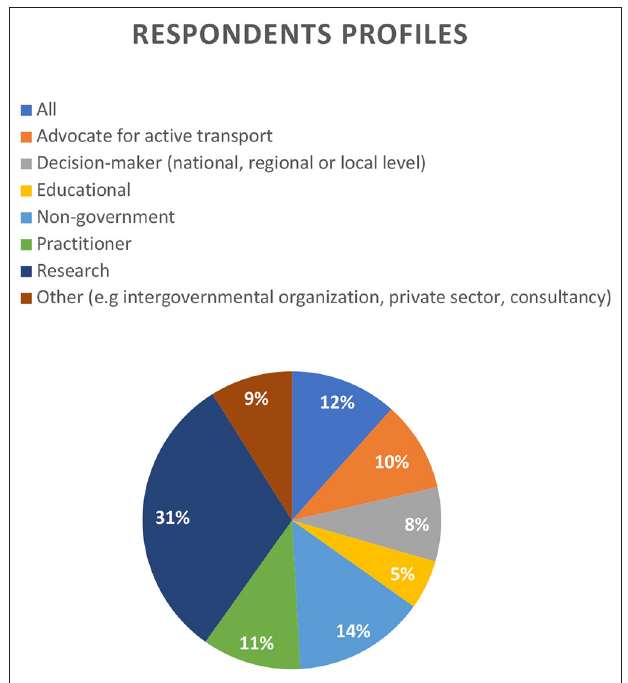
FIGURE 1 | Respondents’ professional profiles (“All” indicates that multiple categories are